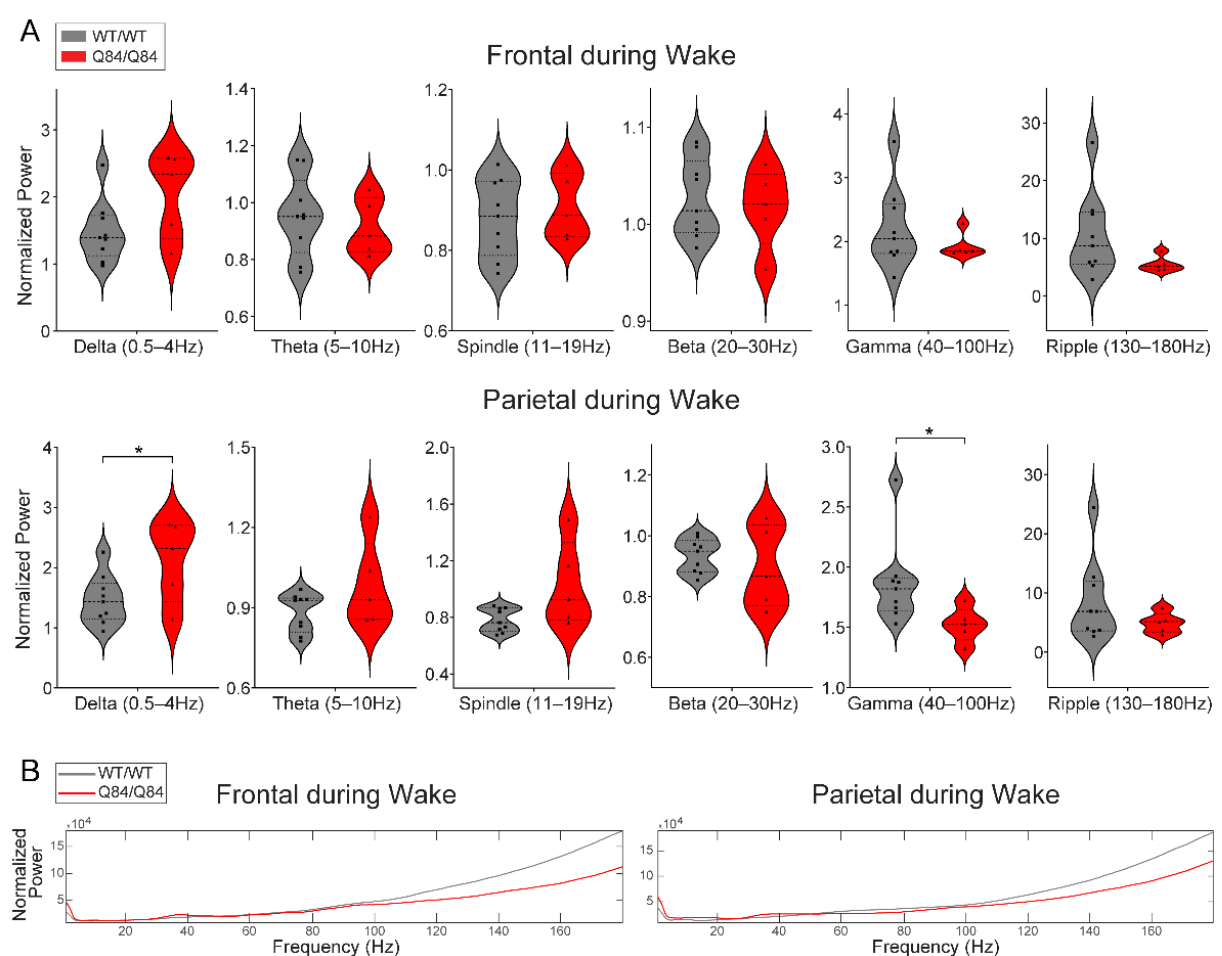
Figure 5. In wake, homozygous Q84/Q84 mice show decreased parietal gamma power. ( A ) Homozygous Q84/Q84 mice (red, n = 5) show increased delta and decreased gamma power in the parietal area during wake when compared to their wild-type WT/WT (grey, n = 9) littermates during wake. In violin plots, squares and triangles represent individual values for wild-type and homozygous mice, dashed lines display the median, and dotted lines show quartiles. ( B ) The total power averaged across all seconds of wake for each genotype is plotted for better visualization. Normalization by dividing over the total median value across the full recording was kept to allow for consistency with data in part A, but that creates the upward trend towards higher frequency bands. All plots display results that come from the 12 h lights-on period (zeitgeber time (ZT) 0–12) and power is normalized by dividing over the respective frequency’s median value. Statistical difference according to independent t -test or Mann–Whitney test. Significance as * p < 0.05.